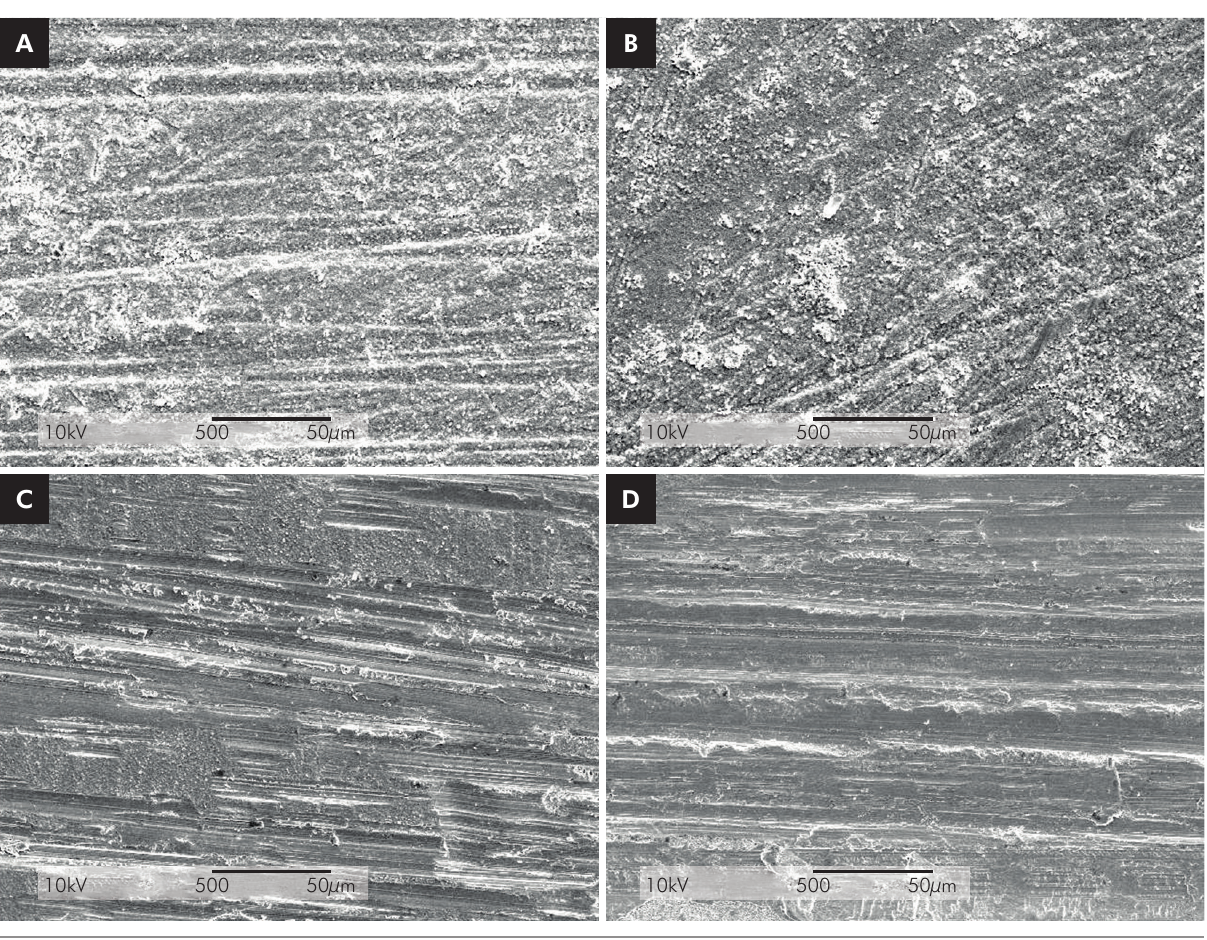
Figure 1. Representative images (SEM - 500×) showing surface topography. Scratches can be noted for ground samples, while no relevant alteration is observed for aged samples